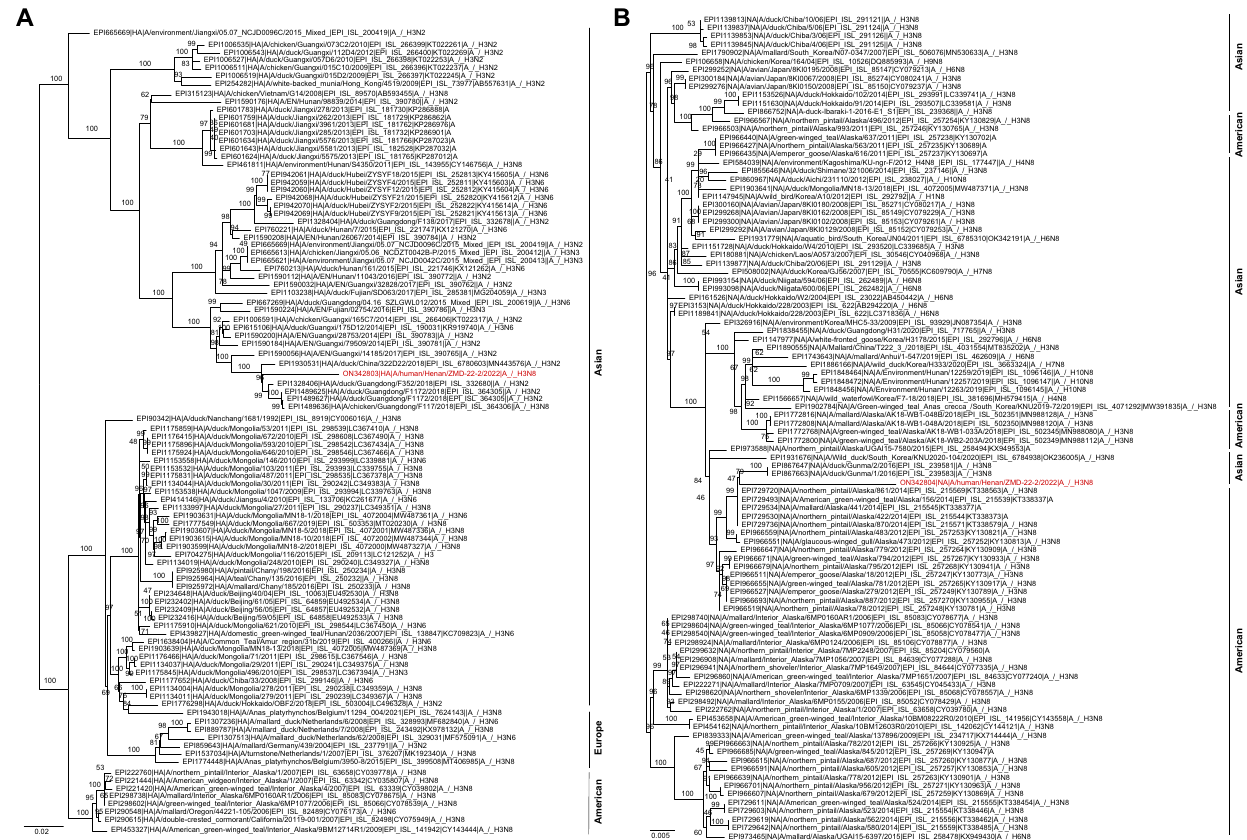
Fig.3|PhylogenetictreesofgenesoftheA(H3N8)in fl uenzavirus. Phylogenetictreesforthefull-lengthHA( A )andNA( B )genesofH3andN8subtypein fl uenzaviruses. A/Henan/ZMD-22-2/2022(H3N8) virus was indicated with red